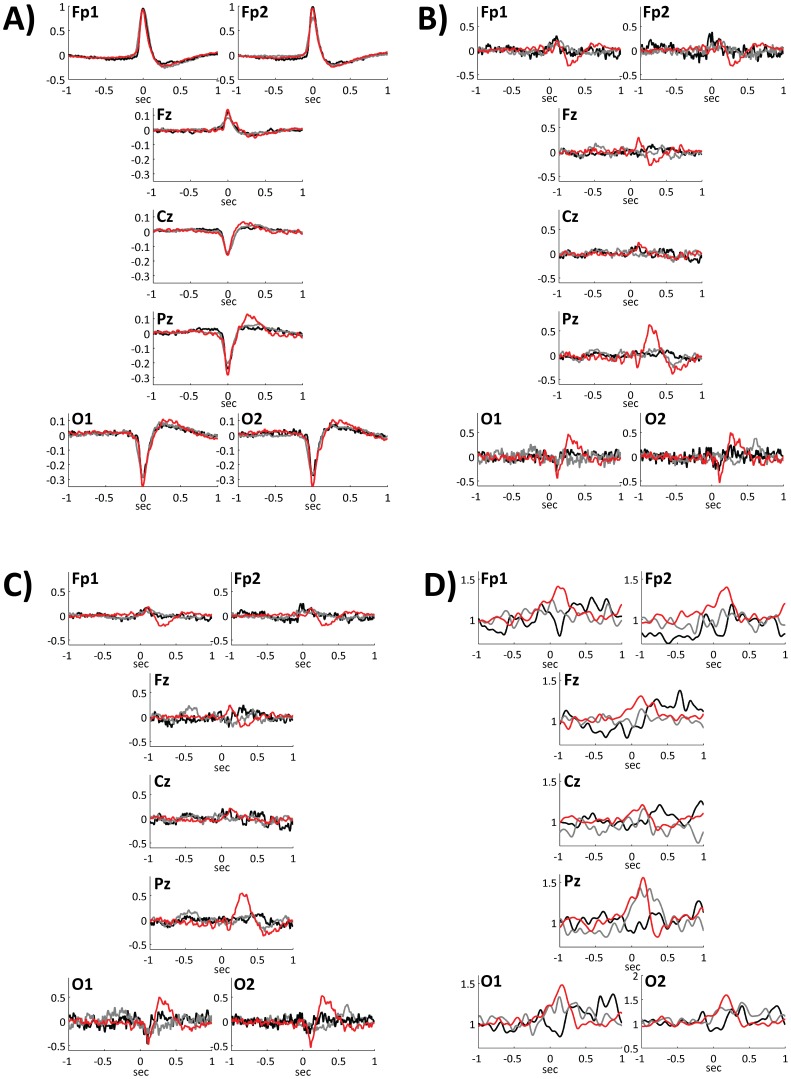
Blink trials: processing steps.
Panel A: group-averages of raw blink instances (before ICA pruning) are presented for seven electrode sites. Note that for visualization purposes the y-scales of Fp1 and Fp2 graphs are different from those of other electrodes (blink artifacts on those electrodes were obviously much higher than on the other ones). Panel B: group-averages of raw blink instances after the blink artifact removal are presented. A BRO with a prominent peak on Pz is already apparent at this stage of processing. Panel C: group-averages of blink instances after the blink artifact removal and REST transformation are presented. For all the three panels, the group-averaged signal for each electrode site was obtained mediating between subjects traces. Prior to the group-averaging, traces related to the single subject were normalized to the maximum amplitude of traces over the scalp. Panel D: group-averaged ERSPs in low-beta bands are presented for the three groups. In all the four panels red traces indicate CTRL subjects, gray traces MCS subjects and black traces VS/UWS subjects.